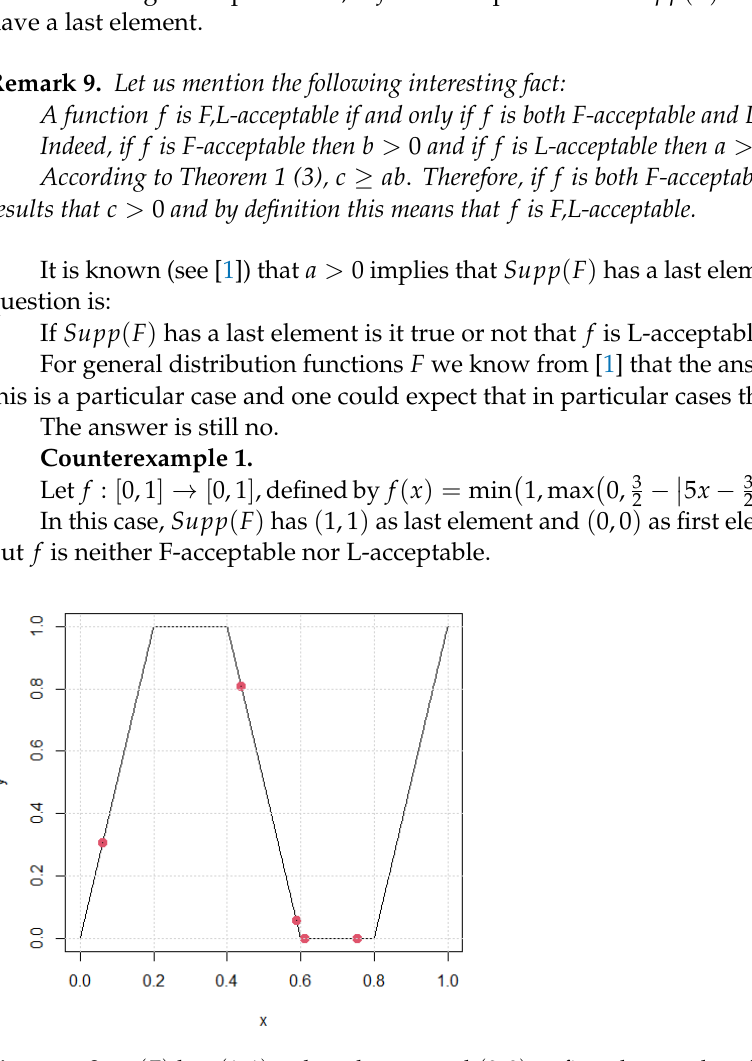
Figure 1. Supp ( F ) has ( 1,1 ) as last element and ( 0,0 ) as first element, but f is not F,L-acceptable. The marked set of five points has neither first nor last